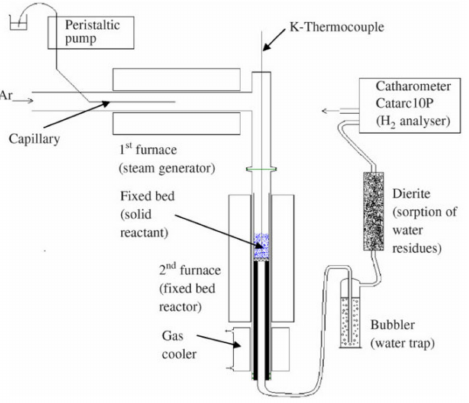
Figure 3. Schematic representation of the experimental setup used for the oxidation of FeO to Fe 3 O 4 for hydrogen production. Reprinted from [45].